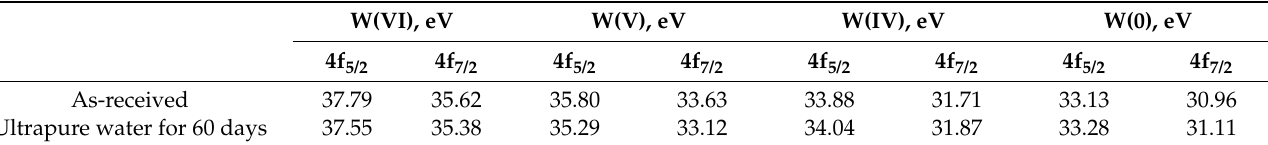
Figure 6. The deconvolution of spectra for the W 4f levels of ( a ) as-received tungsten and ( b ) tungsten in ultrapure water for 60 days. Table 2. The peak positions of all W oxides in XPS spectra of as-received tungsten and tungsten in ultrapure water for 60 days.